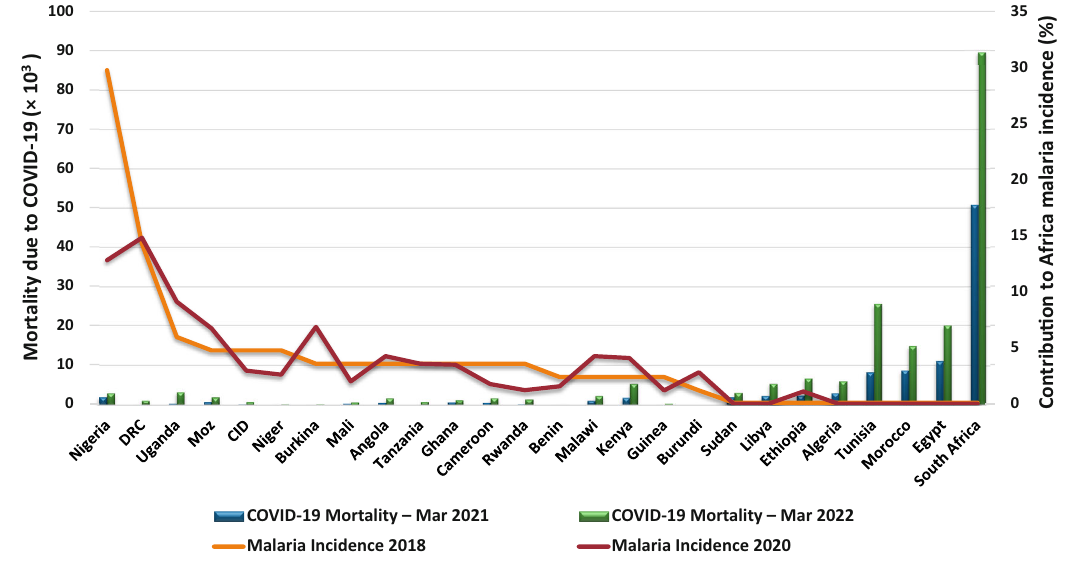
Figure 1. Overlap between COVID-19-related mortality and occurrence of malaria across Africa. Sources: https://www.statista.com/, https://covid19.who.int/; Accessed September 8,